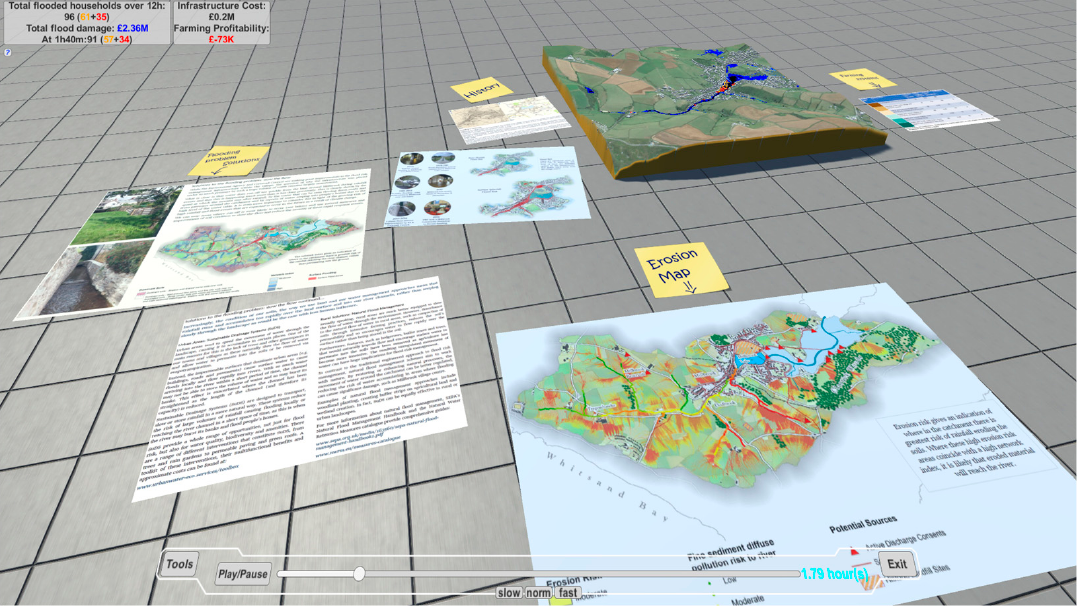
Figure 2. Overview of the 3D virtual table with narrative and interactive elements.